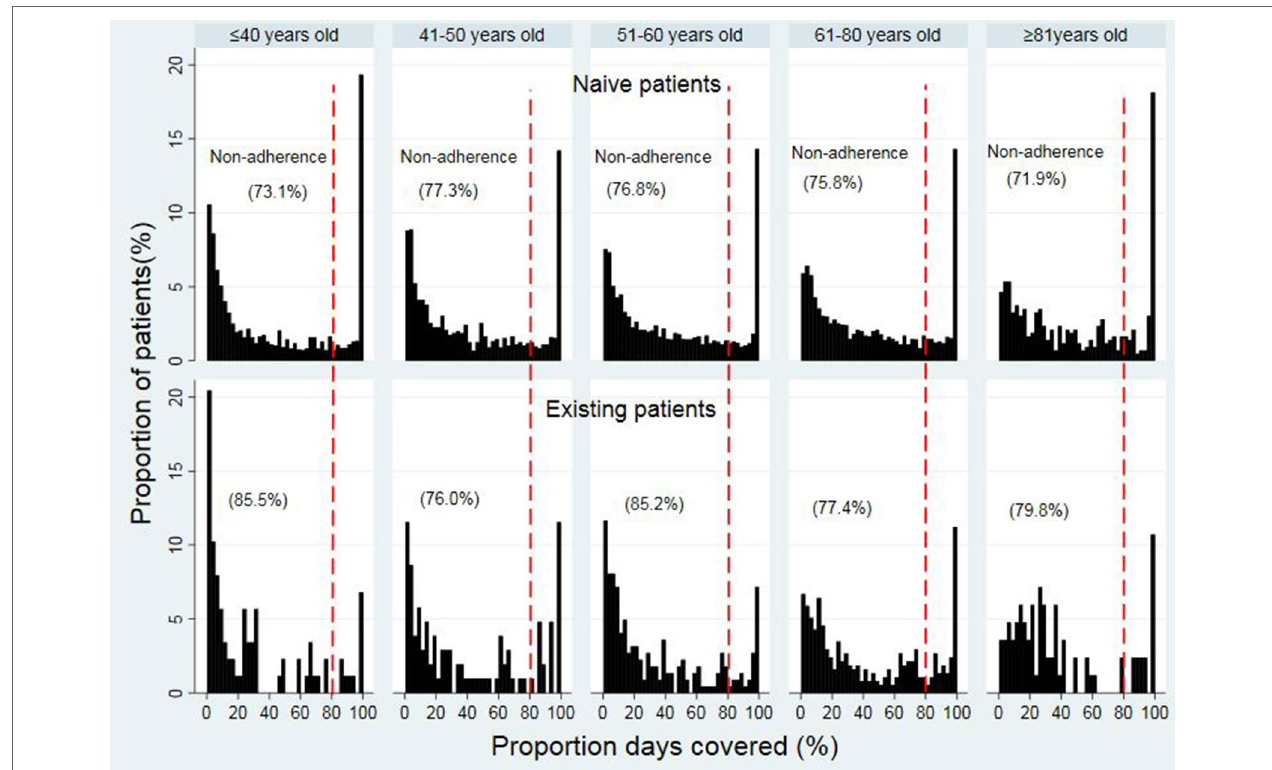
FiGUrE 3 | Proportion days covered in opioid naïve and existing patients in different age groups.